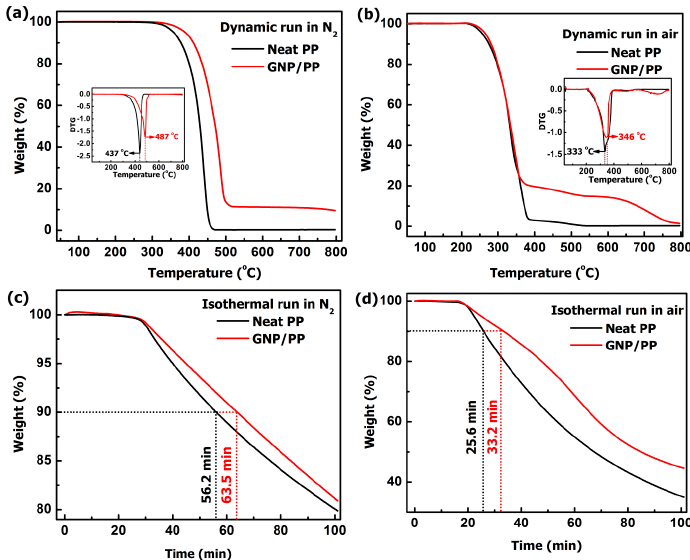
Figure 4. TGA curve of neat PP and 10 wt % GNPs ( a ) dynamic run in N 2 with differential thermogravimetric analysis (DTG) ( b ) dynamic run in air with DTG ( c ) isothermal run at 350 °C in N 2 ( d ) isothermal run at 250 °C in air.